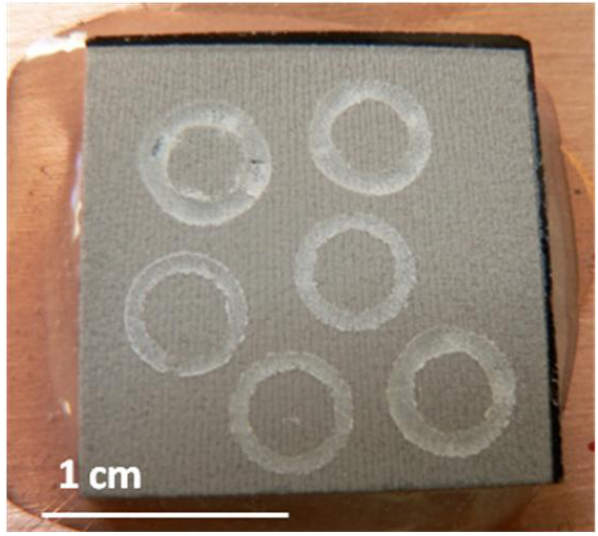
Figure 8. Appearance of the wear track in the unpolished glass-ceramic porous layer performed against corundum